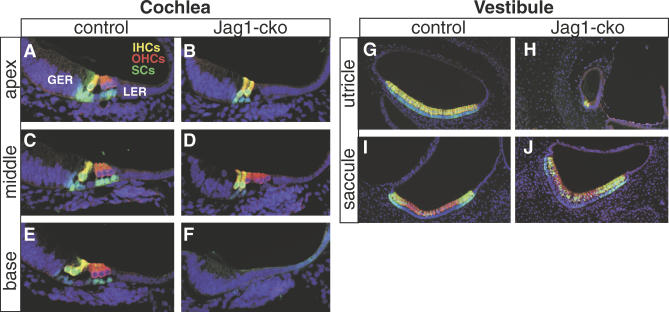
Hair and Supporting Cell Markers Demonstrate Sensory Areas Are Reduced or Absent in the Jag1-cko Inner EarImmunocytochemistry using two markers, myosin VIIA (red; all hair cells) and S100a (green; inner hair cells, Dieter's cells, and inner phalangeal cells) demonstrate patterns of hair and supporting cell production at E18.5 in control and Jag1-cko inner ears.(A–F) Sections through the indicated turns of the cochlea. Note the different hair cell patterns in the apical, middle and basal turns of the Jag1-cko cochlea. Normal morphology is shown (A) along with labeled structures, as follows: GER, greater epithelial ridge; IHCs, inner hair cells (color-coded yellow); LER, lesser epithelial ridge; OHCs, outer hair cells (color-coded red); SCs, supporting cells (color-coded green).(G–J) Patterns of hair and supporting cell production in the vestibular system. The utricular macula is extremely small with very few hair cells (H) while the saccule (J) shows robust hair and supporting cell production although the shape of the organ is smaller and malformed.